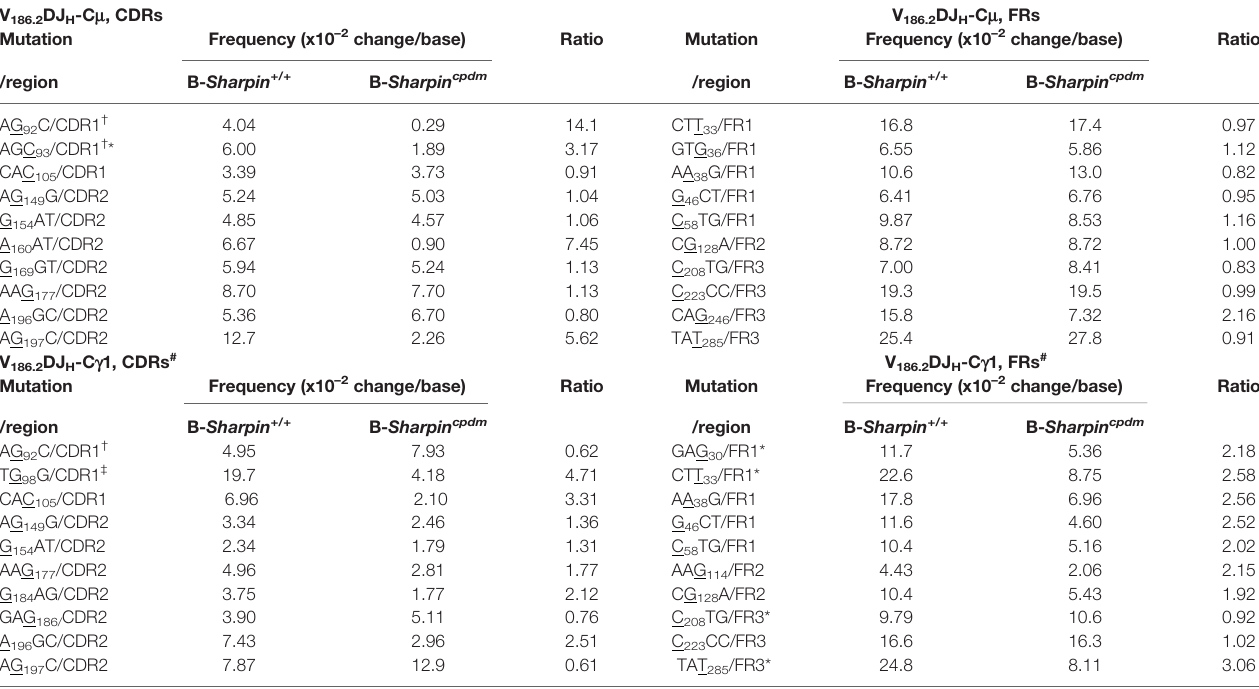
TABLE 1 | Distribution and frequencies of dominant V 186.2 mutations in B- Sharpin +/+ and B- Sharpin cpdm mice immunized with NP-CGG and the ratio of mutation frequencies in B- Sharpin +/+ mice to those in B- Sharpin cpdm mice. V 186.2 DJ H -C m , CDRs V 186.2 DJ H -C m , FRs